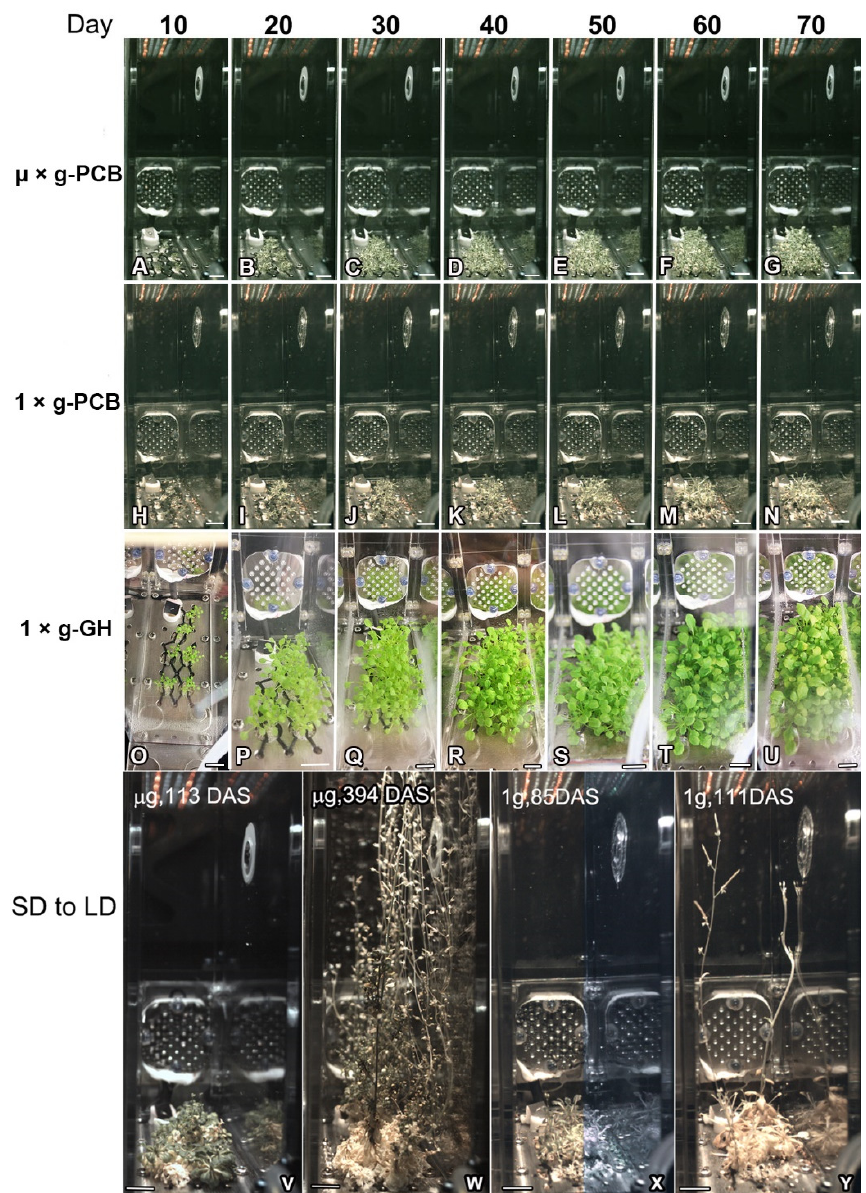
on ground ( X , Y ). ( V’ , X’ ) Enlarged images of the red framed area in ( V ) and ( X ), respectively. Note that flowers could not fully open in space ( V’ ) in comparison with that of the ground controls ( X’ ). µ × g -PCB, in PCB under microgravity in space. 1 × g -PCB, in PCB under the normal gravity (1 × g ) on ground. 1 × g -GH, in greenhouse under the normal gravity on ground. Scale bar = 10 mm in ( A – Y ); 5mm in V’ and X’. 5 mm in ( V’ , X’ ).